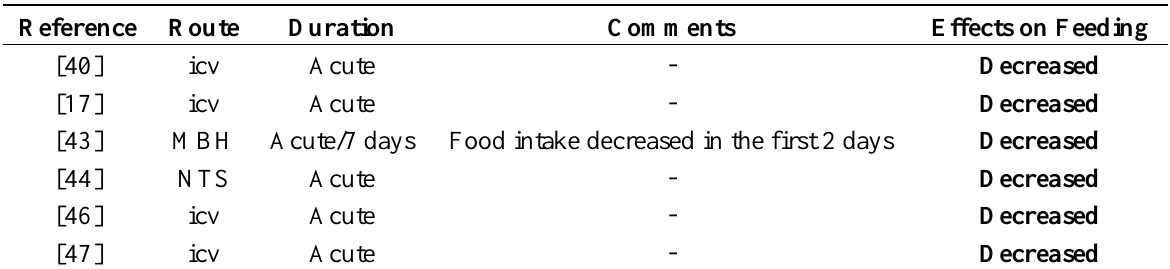
Table 1. Summary of the studies that investigated the effects of central leucine treatment on feeding.